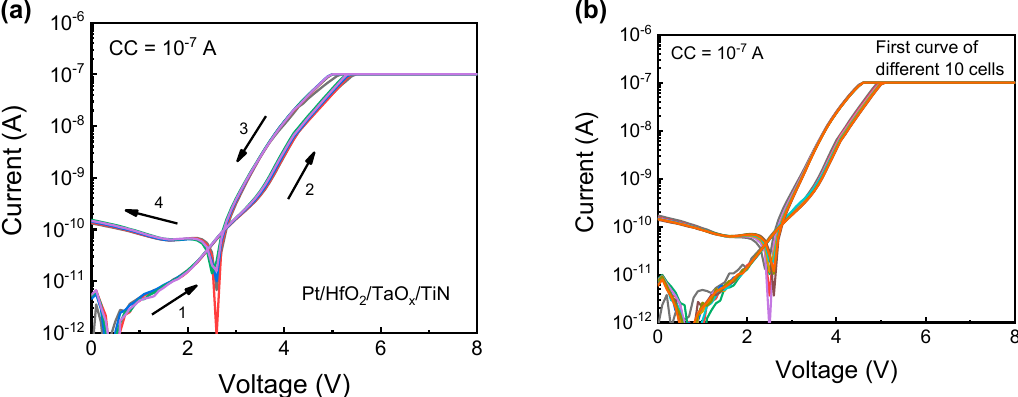
Figure 2. I-V characteristics of Pt/HfO 2 /TaO x /TiN RRAM device. ( a ) Ten cycles in one cell and ( b ) first curves of 10 cells.